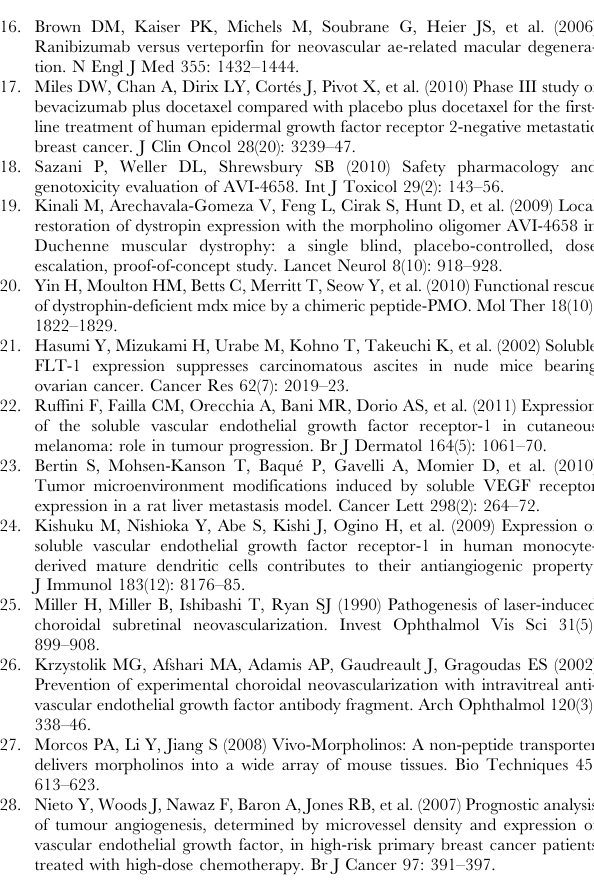
Figure S1 The Soluble/Membrane FLT-1 ratio increases following electroporation of VEGFR1_MOe13 into HUVEC.